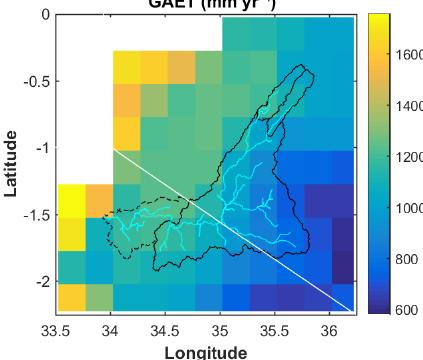
Figure 2. Annual mean of GAET over the entire Mara River